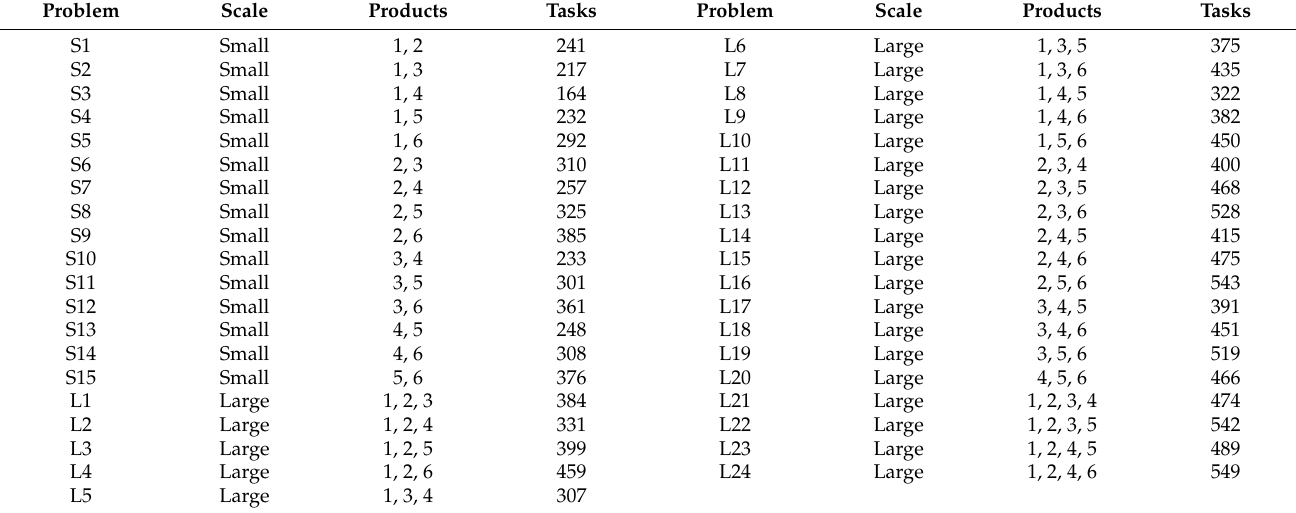
Table 5. Details of the 39